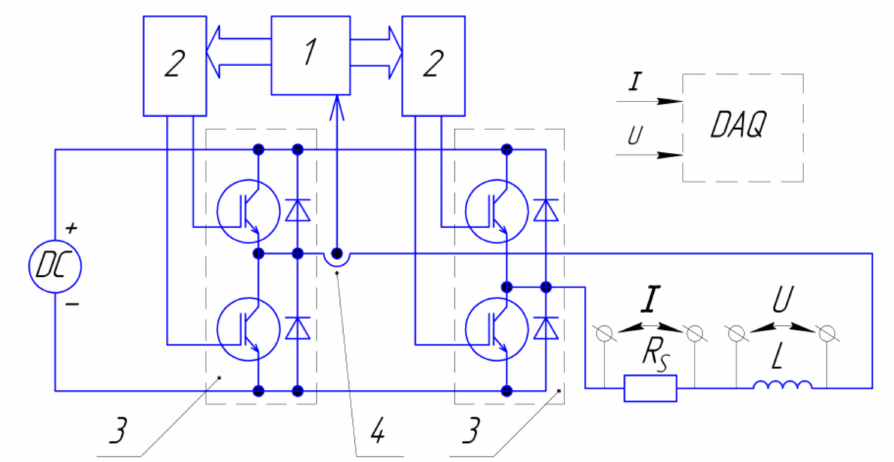
Figure 2. Inverter simulator for HTS devices. 1—microcontroller, 2—transistor drivers, 3—transistor assemblies with built-in protection diodes, 4—feedback sensor, ( DC )—laboratory power source, ( Rs )—noninductive current shunt, ( L )—device under test, and ( DAQ )—data acquisition